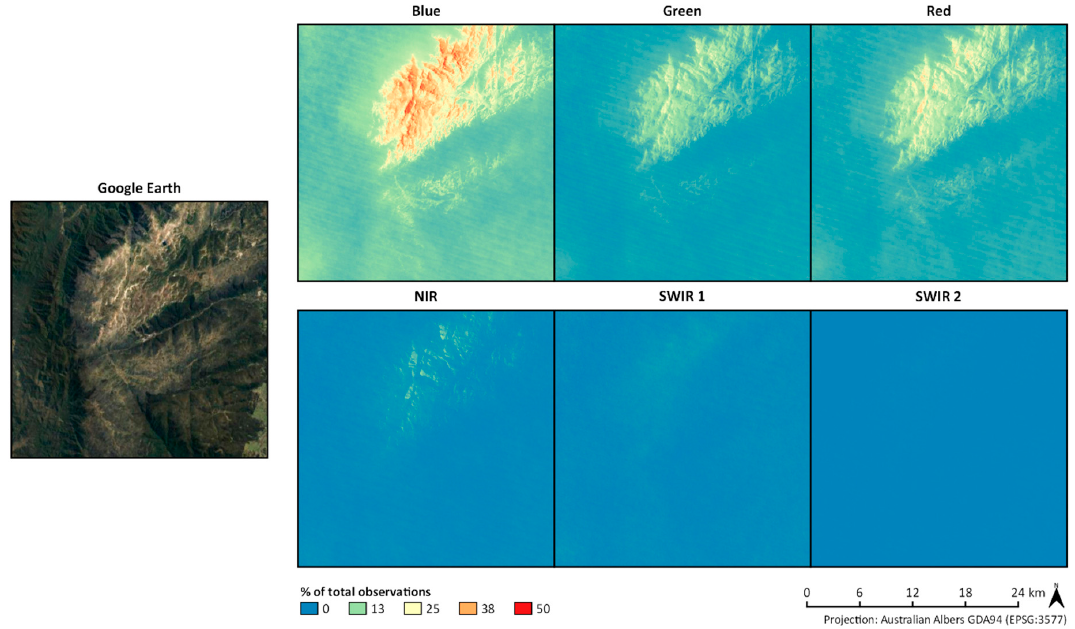
Figure 11. High-resolution imagery (Google, CNES/Airbus, DigitalGlobe), saturation flags in the visible, NIR, and SWIR bands in percent of total observations; Mt Kosciuszko National Park, NSW.